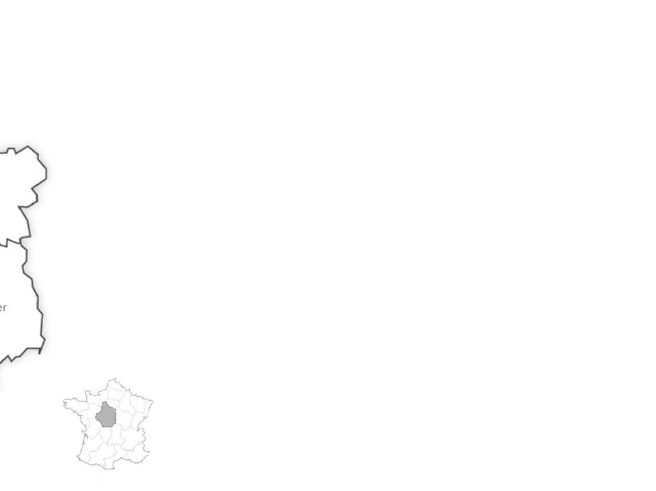
Table 1. Descriptive characteristics of the study sites. Presented are site number, stand type, treatment, main harvested species and basal area in m 2 ha − 1 before the harvest.